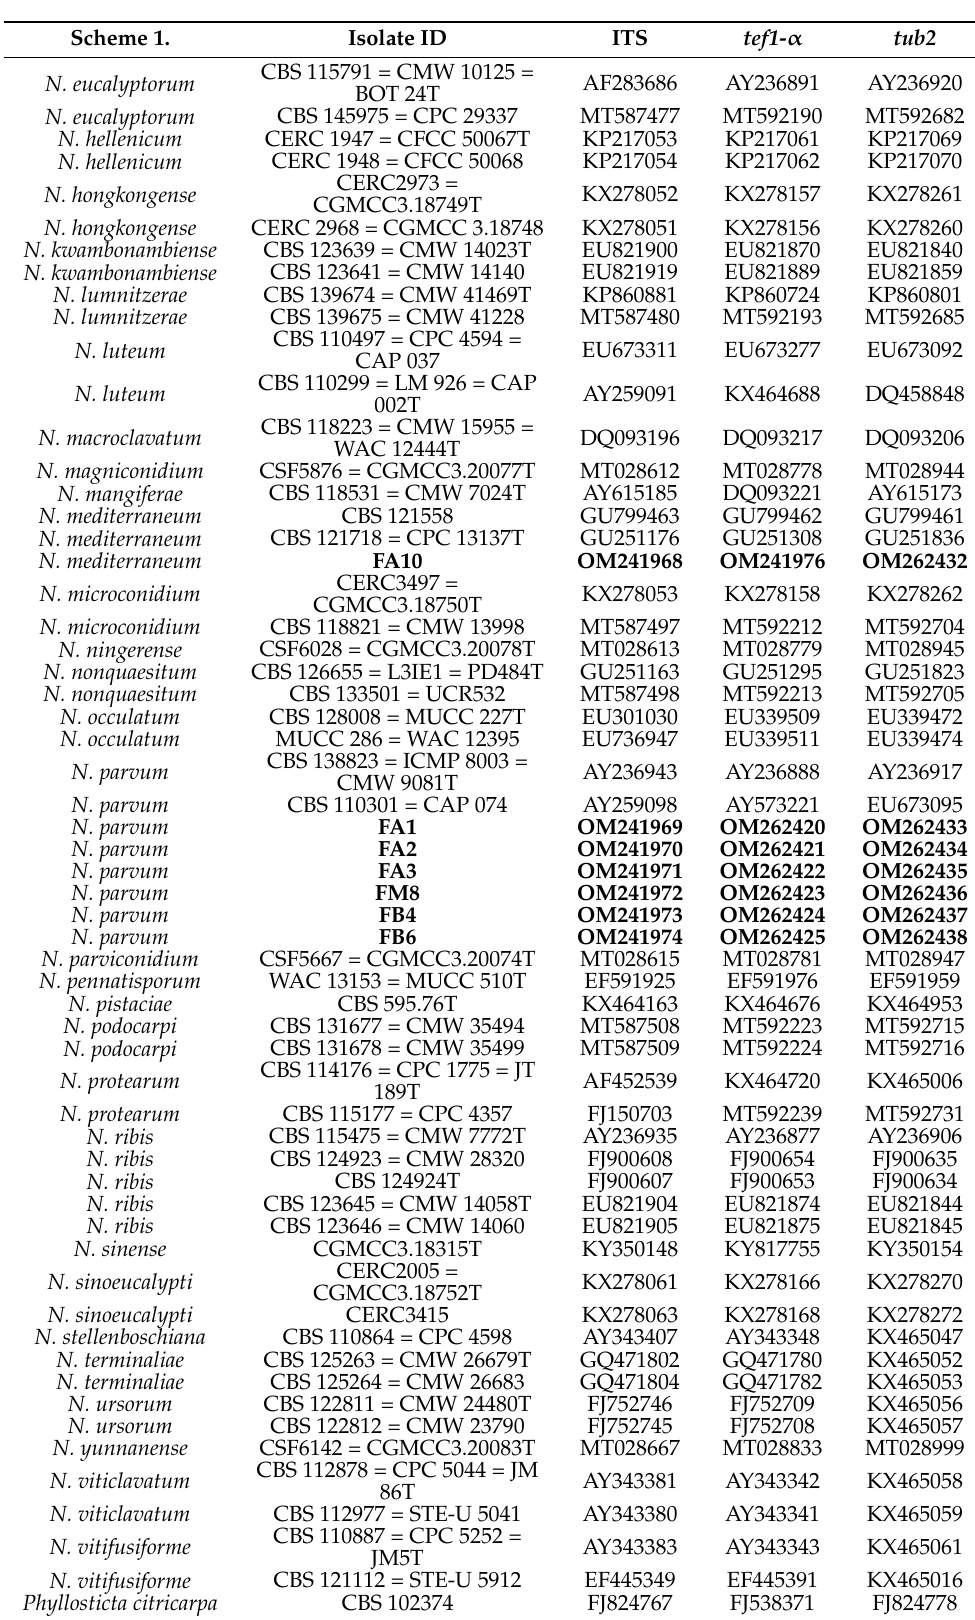
Table 1. Cont . Scheme